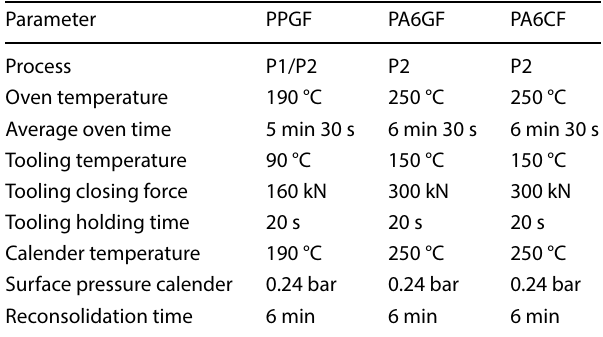
Table 2 Parameters of recovery processes in dependence on differ- ent materials